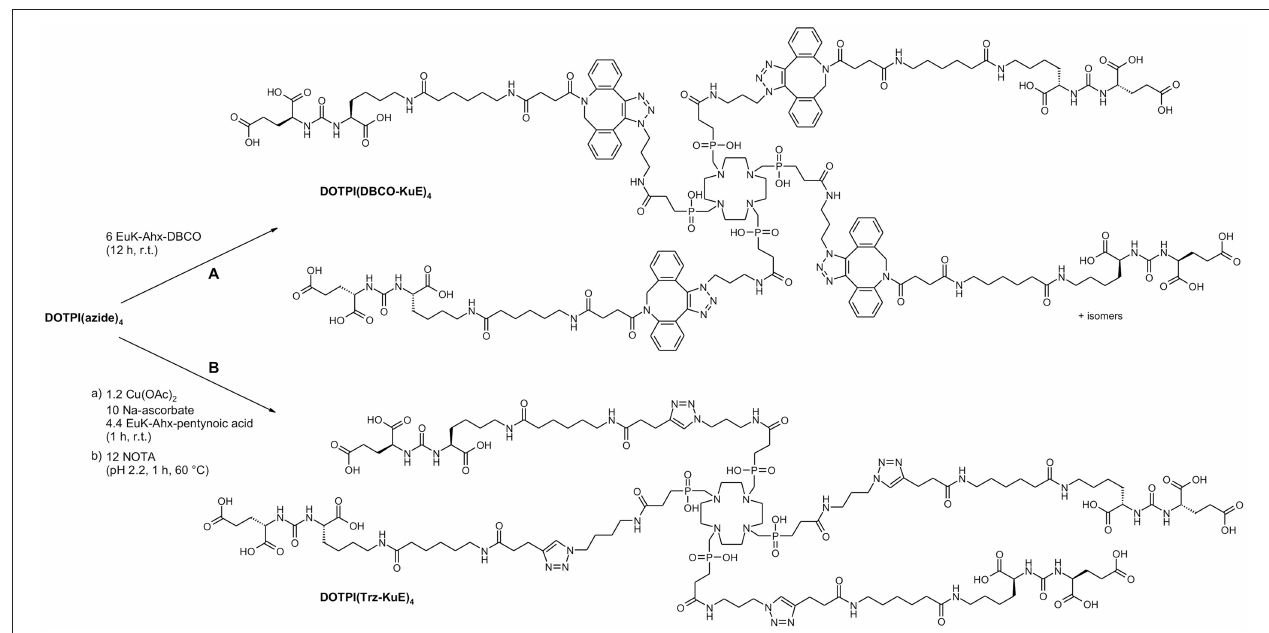
FIGURE 5 | Synthesis of symmetrical tetrameric prostate-specific membrane antigen (PSMA) inhibitor conjugates via DBCO-driven, strain-promoted (SPAAC, path A ), or Cu I -catalyzed (CuAAC, path B ) alkyne-azide cycloaddition (Huisgen-reaction).